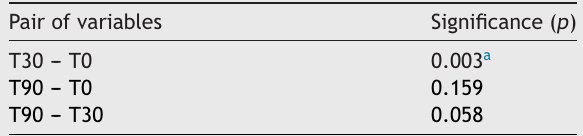
Analysis of shimmer (S) --- Vowel /u/.